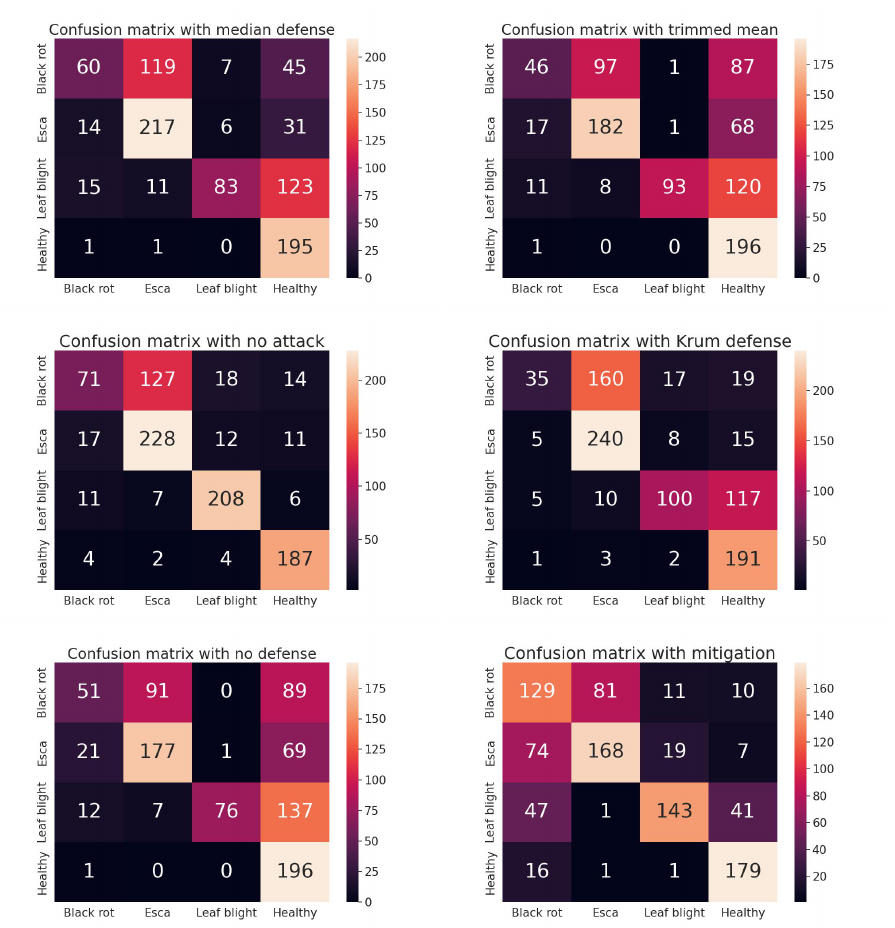
Figure 7. Confusion matrices for the targeted label attack with different aggregation